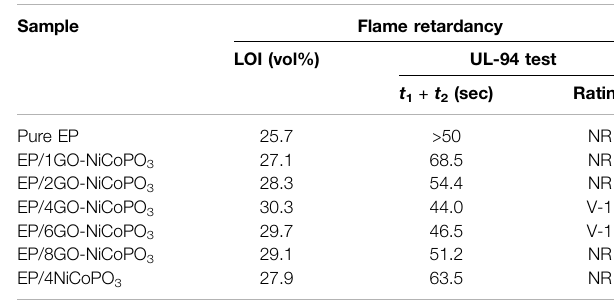
TABLE 3 | LOI and UL-94 results of pure EP and EP